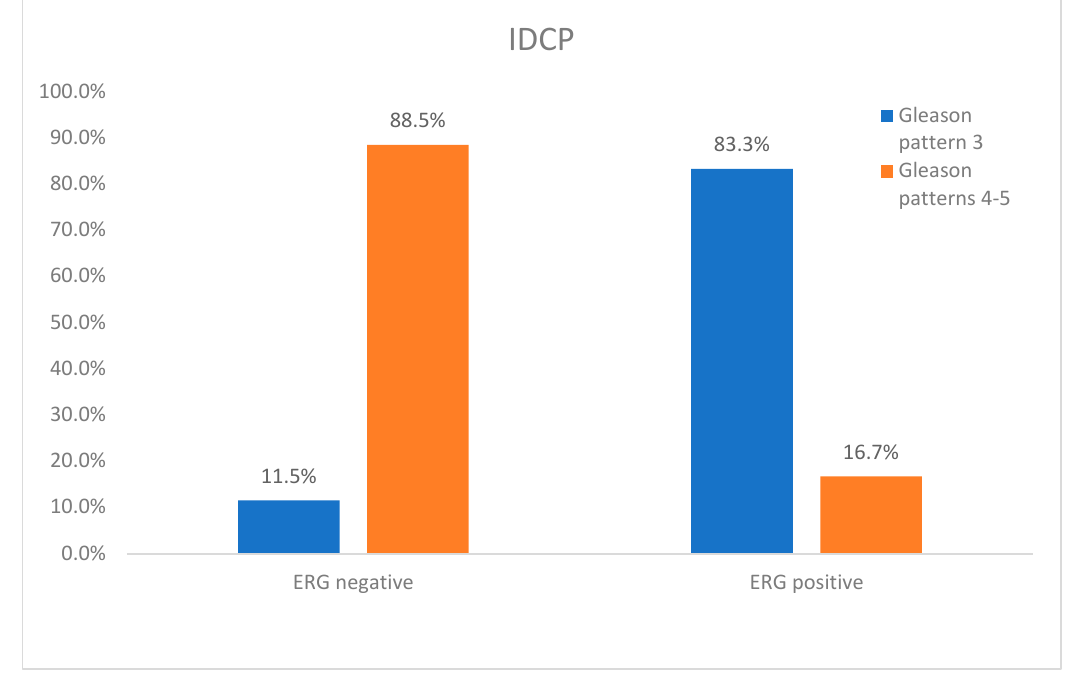
Figure 8. ERG immunoexpression of IDCP in relation to ERG expression and Gleason grade pattern of the adjacent invasive carcinoma.